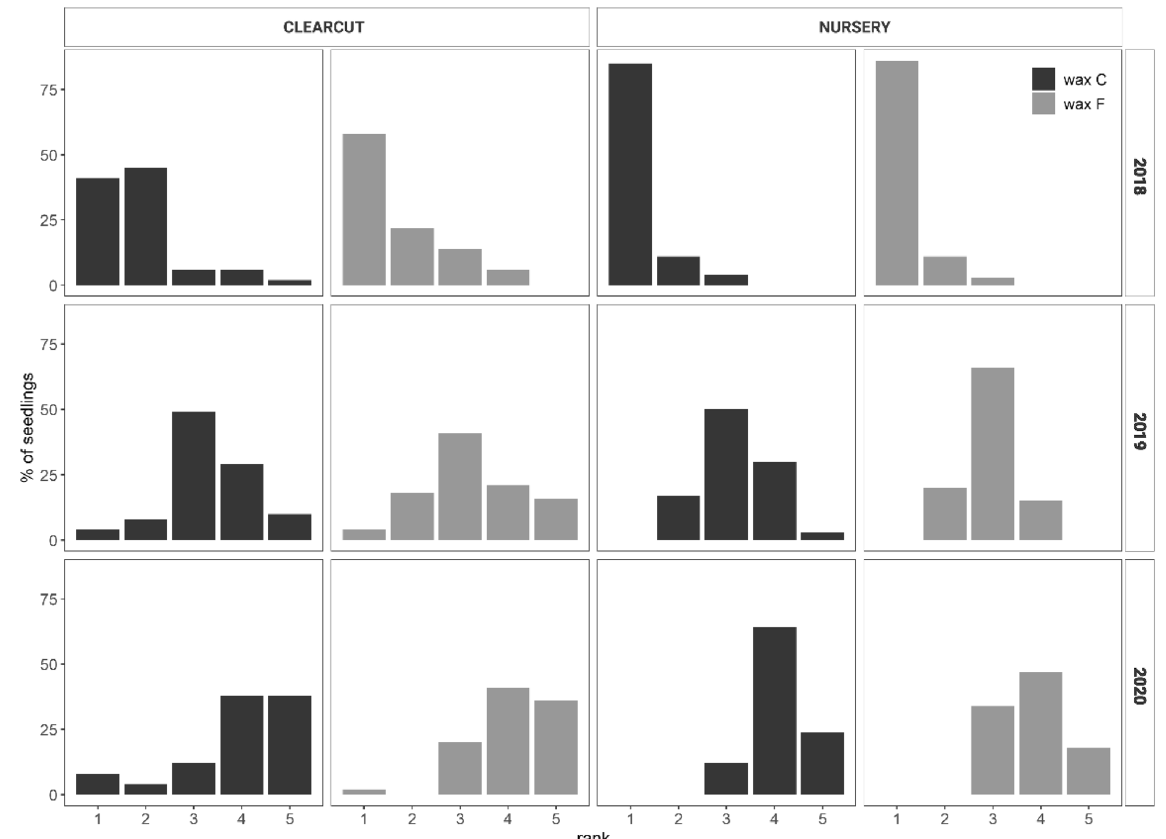
Figure 5. Distribution of quality (ranked on a scale from 1 to 5 for the two wax types at two sites and for 3 years of the experiment. Wax quality was ranked on a scale from 1 highest quality to 5 lowest